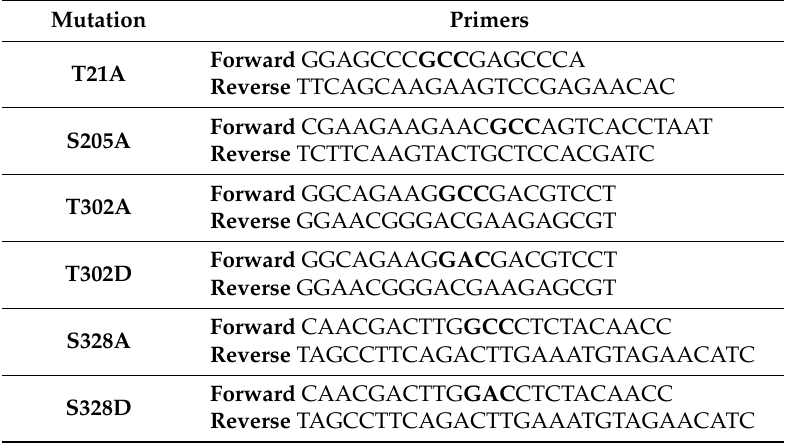
Table 2. PCR primers designed to perform site-directed mutations of amino acid residues of rPanx1.